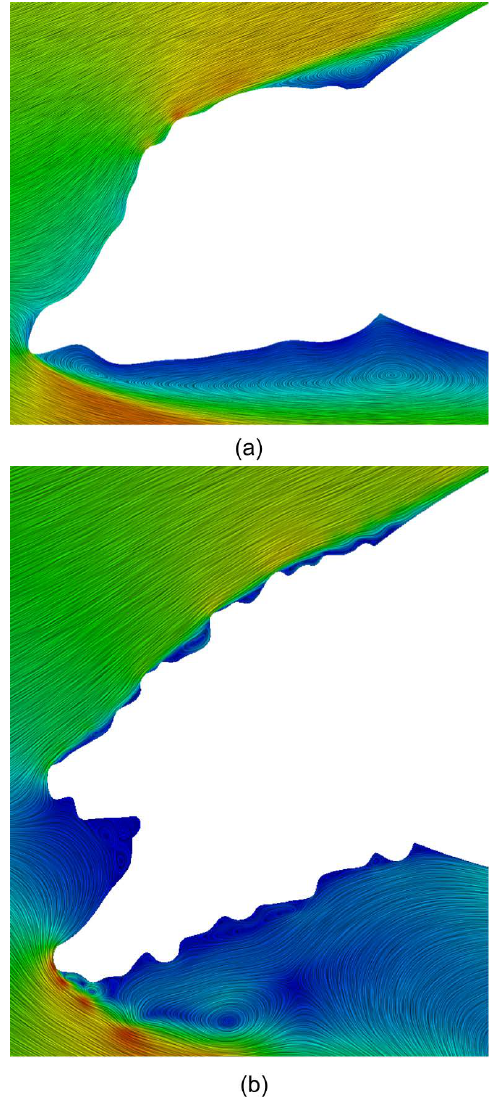
Figure 16. LIC of flow in ( a ) case 2 at AoA = 0 ◦ ( b ) case 3 at AoA = 0 ◦ .